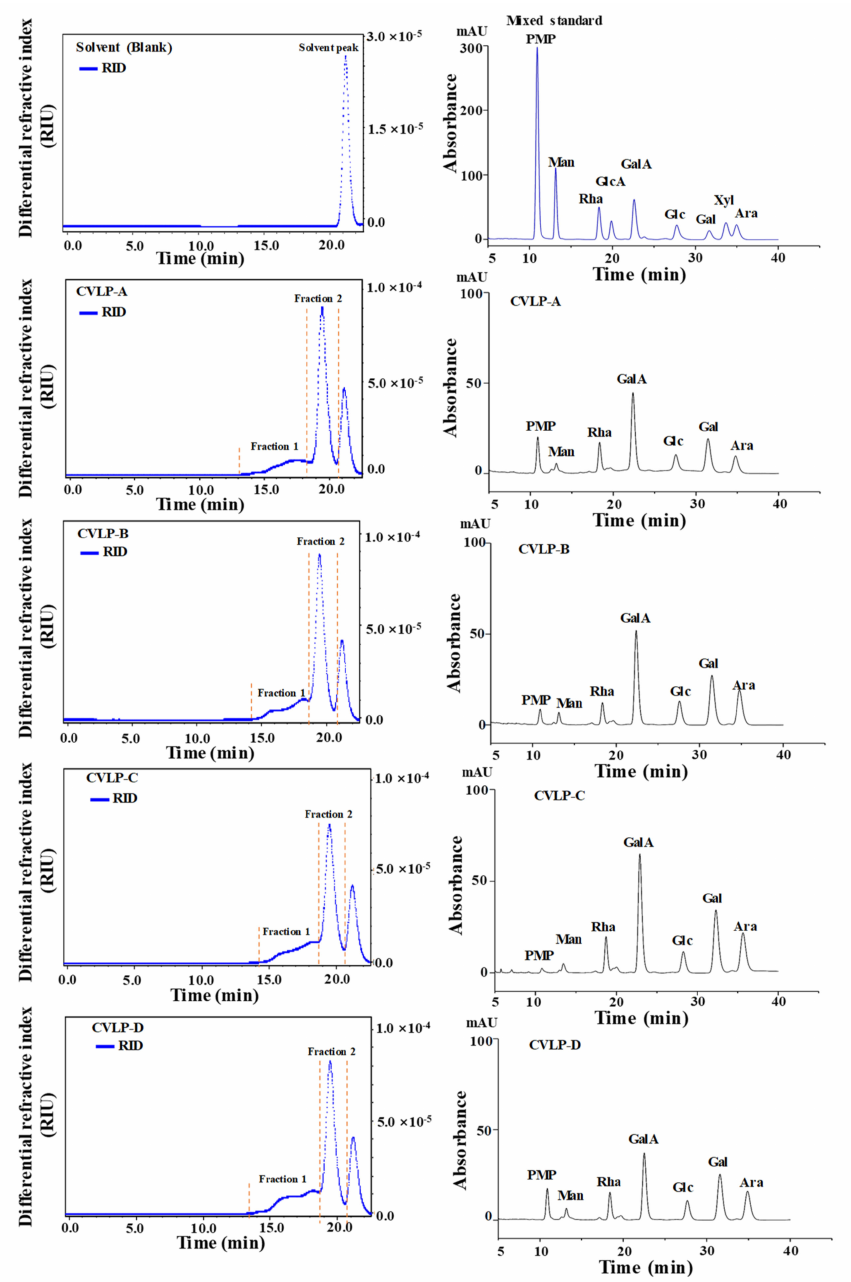
Figure 1. High performance size exclusion chromatograms ( left ) and high-performance liquid chromatography profiles ( right ) of CVLPs. CVLP-A , CVLP-B , CVLP-C and CVLP-D , crude polysaccharides extracted from the leaves of C. violaceum collected from Chengdu, Langzhong, Bazhong and Guangyuan, respectively; PMP , 1-phenyl-3-methyl-5-pyrazolone; Man , mannose; Rha , rhamnose; GalA , galacturonic acid; Glc , glucose; Gal , galactose; Ara ,